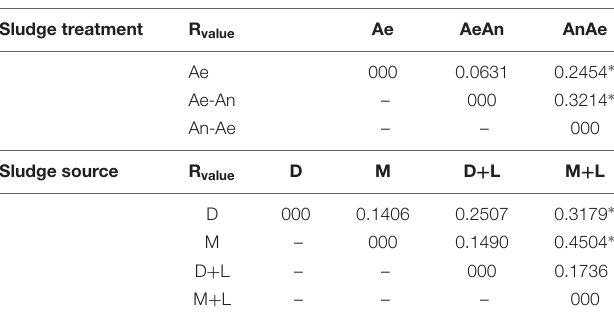
TABLE 3 | Analysis of similarity (ANOSIM) for microbial community structure as affected by sources and treatments of 19 sewage sludges from São Paulo State,